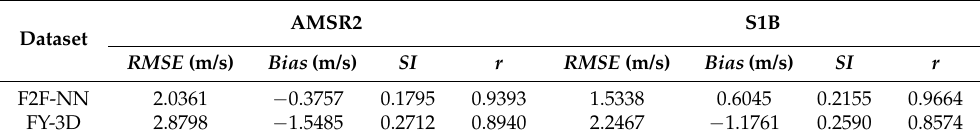
Table 4. The overall comparison results of F2F-NN and FY-3D wind speed with other products.